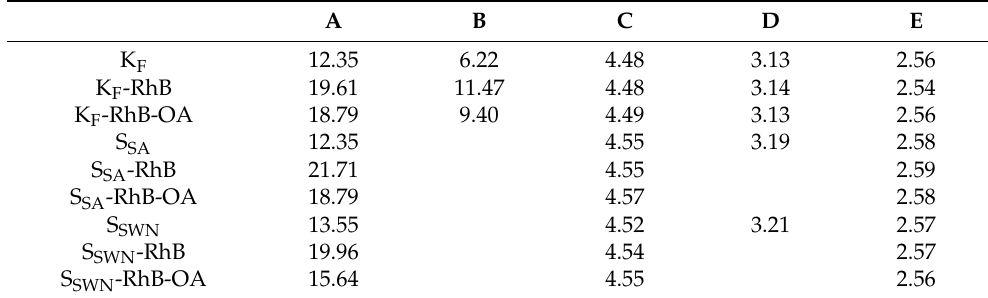
Table 1. Main reflections’ d-Spacing (Å) values for the RhB-loaded organonanoclays obtained